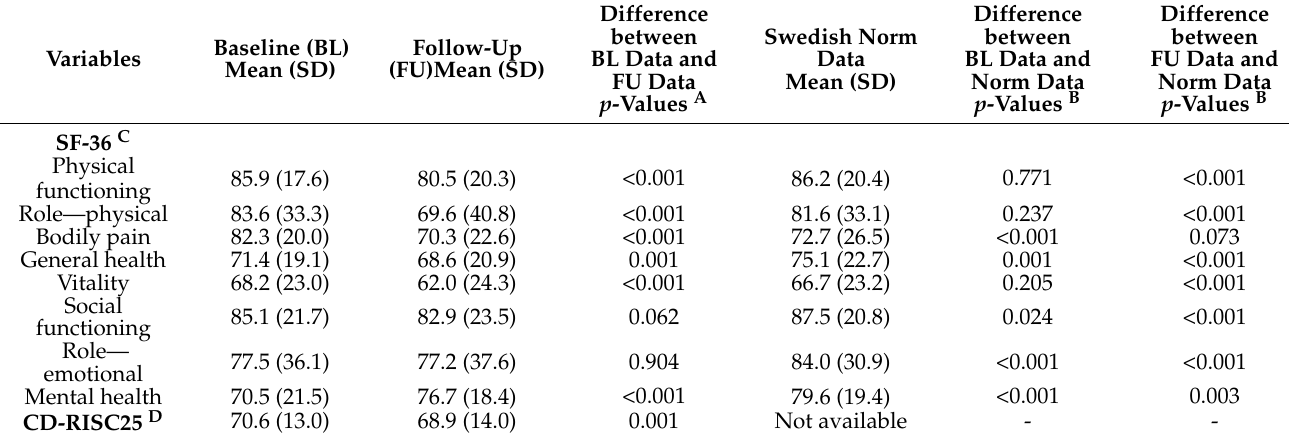
Table 3. Mean scores for health-related quality of life (SF-36) at diagnosis (baseline) and at 1 year post diagnosis (follow-up) and norm values of SF-36. Mean scores for psychological resilience (CD-RISC25) at diagnosis and at 1 year post diagnosis.